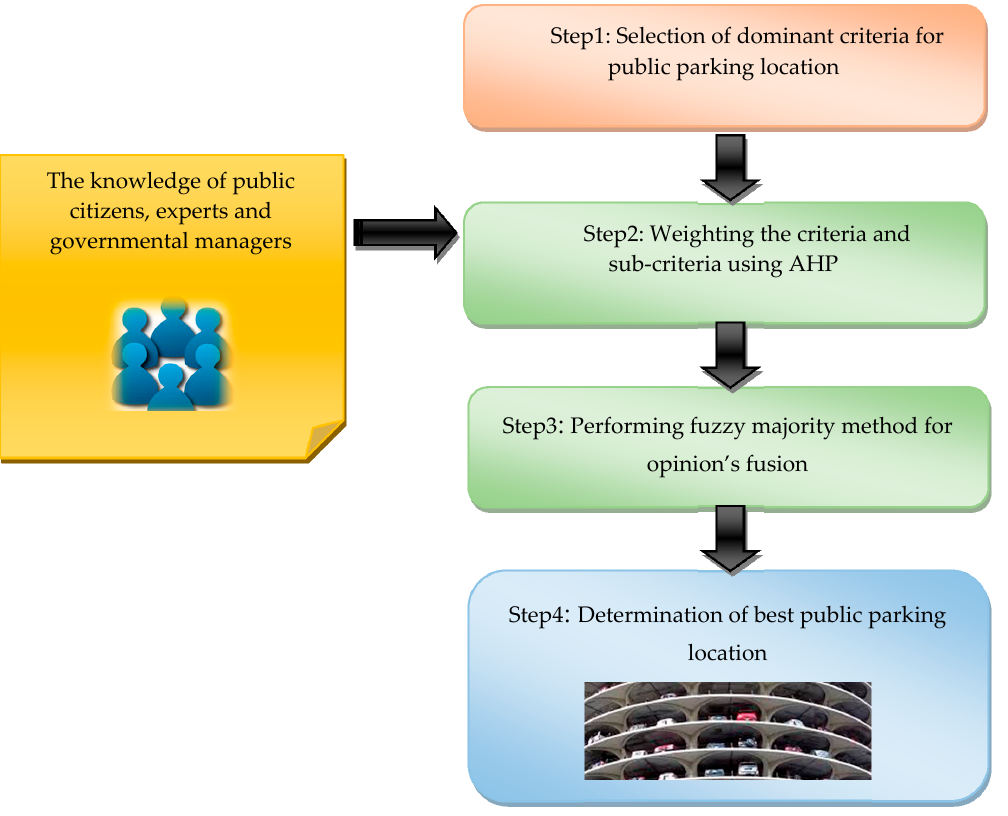
Figure 2. The conceptual framework of the proposed methodology.